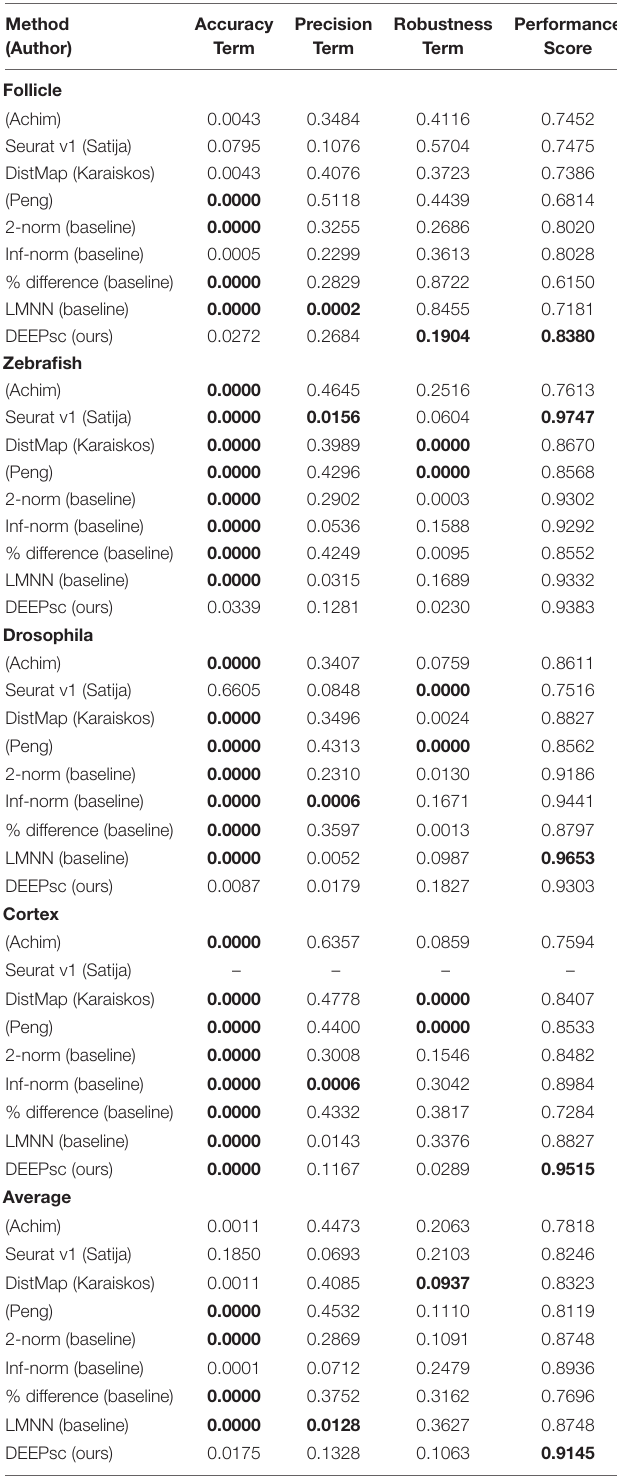
TABLE 1 | Numerical values of each of the three constituent terms of the performance score, as determined from simulated scRNA-seq data for each biological system, as well as the average across all